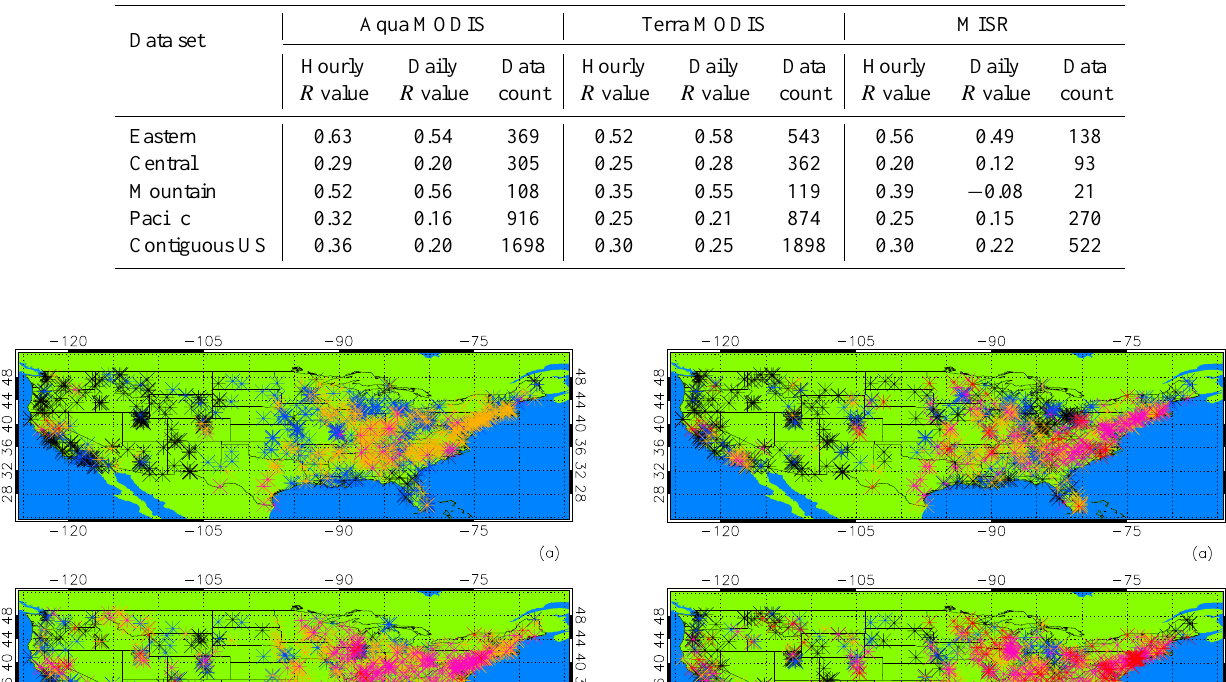
Table 3. Correlation coefficients and data counts for the hourly PM 2 . 5 /40km average operational AOD and daily PM 2 . 5 /1 ◦ × 1 ◦ average DA AOD common point analyses for the eastern, central, mountain, and Pacific time zones and contiguous United States total for the two-year